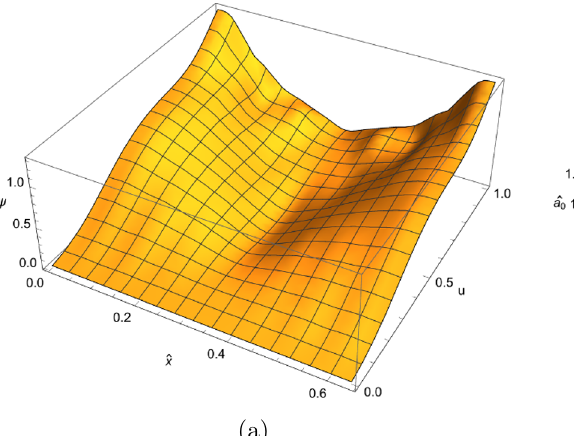
Figure 1 . Plot of and a 0 vs.